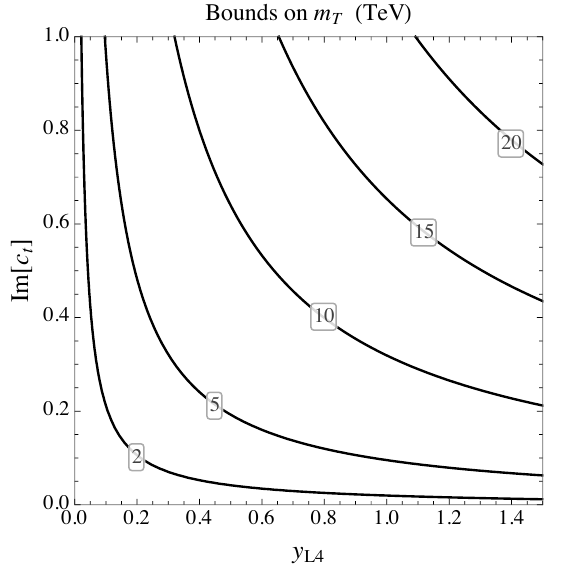
Figure 4 . Bounds on the mass of the top partner derived from the recent ACME results. The bounds are derived by setting f = 800 GeV, although the dependence on f is quite mild. The labels on the solid lines show the top partner mass m T in